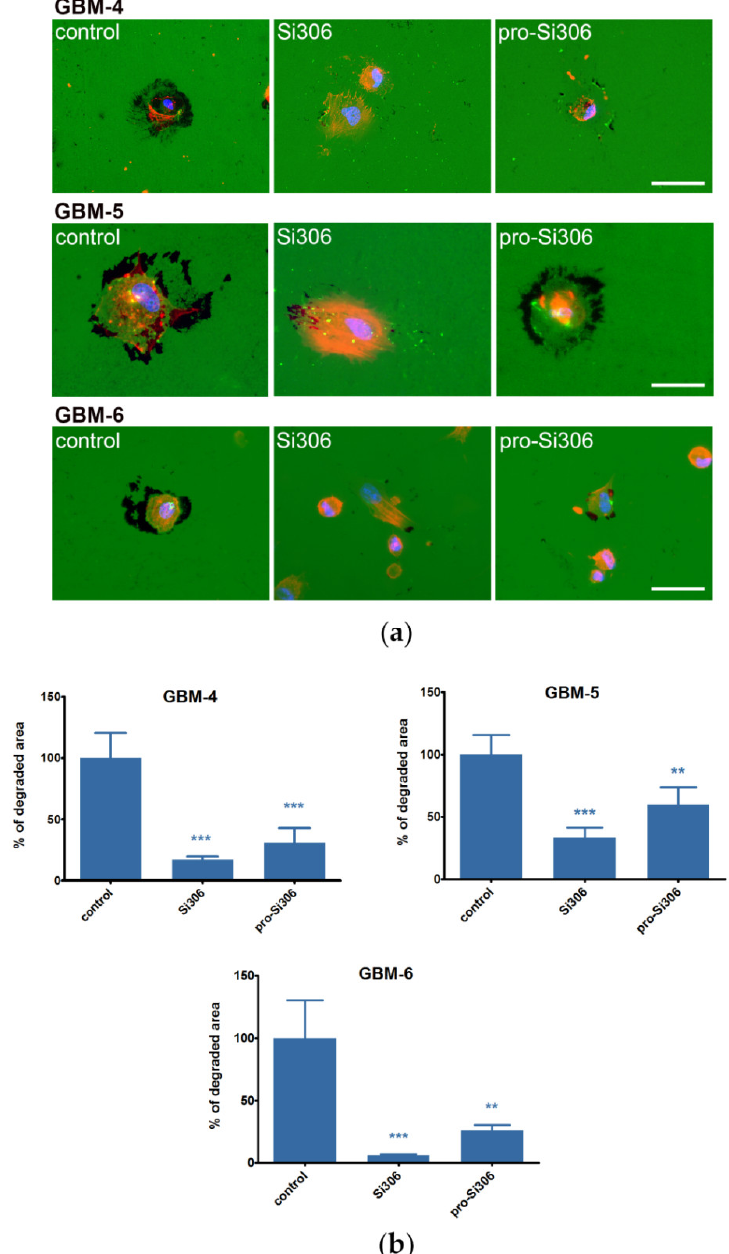
Figure 3. Si306 and pro-Si306 decrease the ability of primary GBM cells to degrade the ECM. ( a ) Representative images of gelatin degradation by primary GBM-4, GBM-5, and GBM-6 cells treated with 10 µ M Si306 and pro-Si306 for 24 h. Scale bar = 30 µ m. ( b ) Percentage of area degraded by primary GBM-4, GBM-5, and GBM-6 cells. Values are expressed as mean ± SEM ( n = 3). Statistical significance between treated and control group is shown as ** ( p < 0.01) and *** ( p < 0.001).